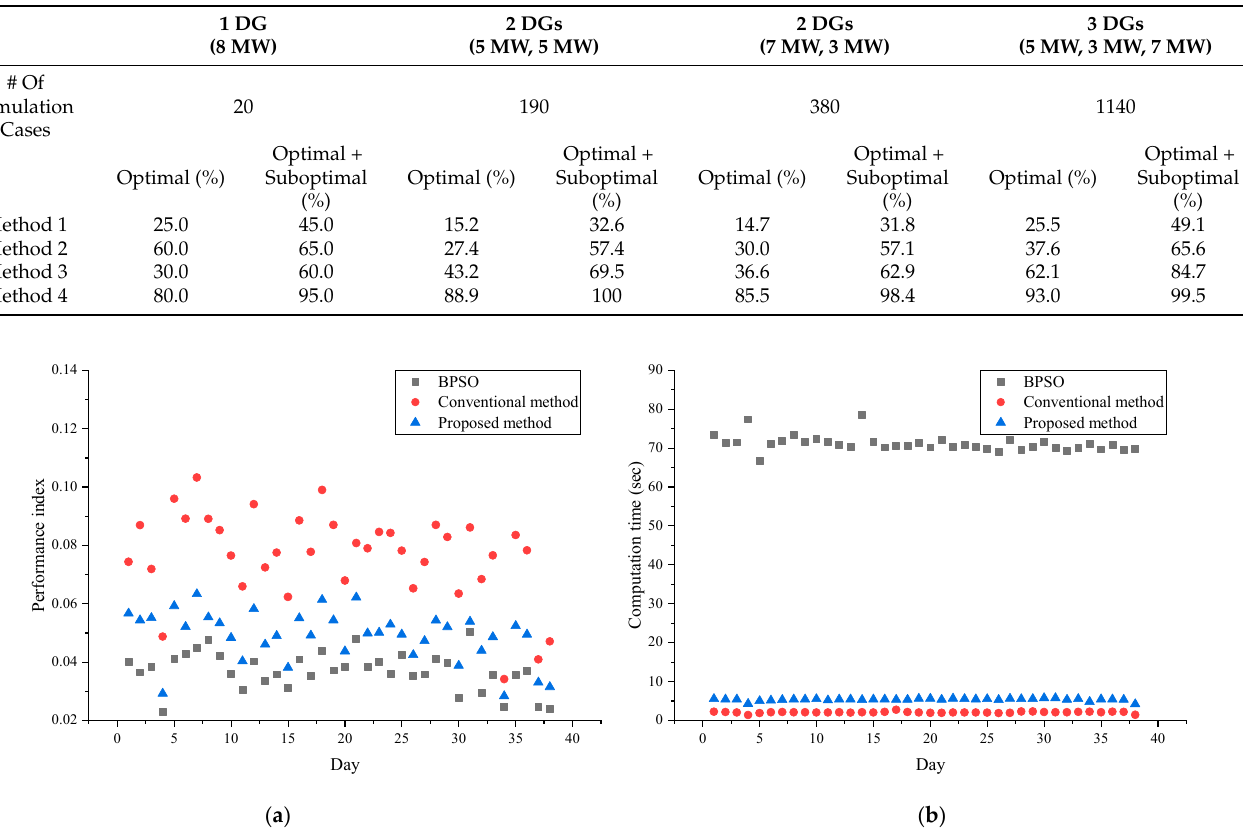
Figure 14. Simulation results of the BPSO, conventional heuristic method, and proposed method: ( a ) performance Index; ( b ) computational time. Table 2. Comparison of the average values of performance index and the computational time for